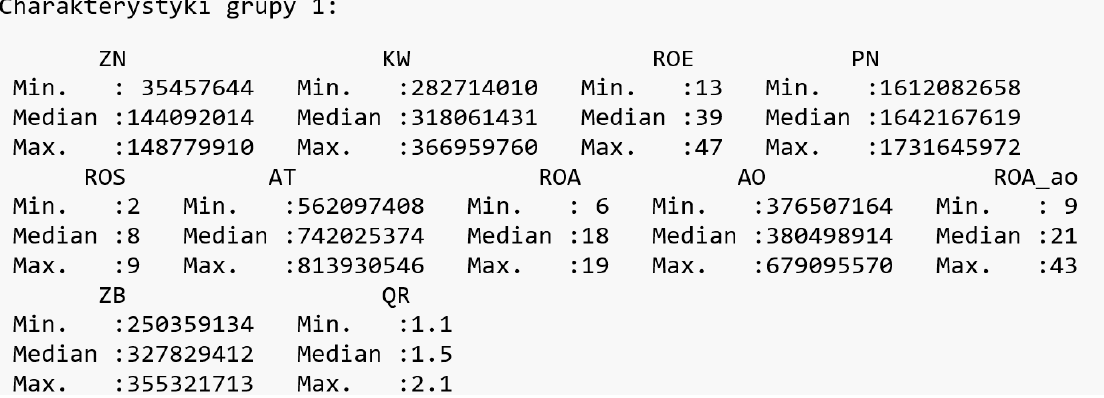
Scheme 2. Characteristics of the subset of leaders based on 2021 variables. Based on own research according to CRAN